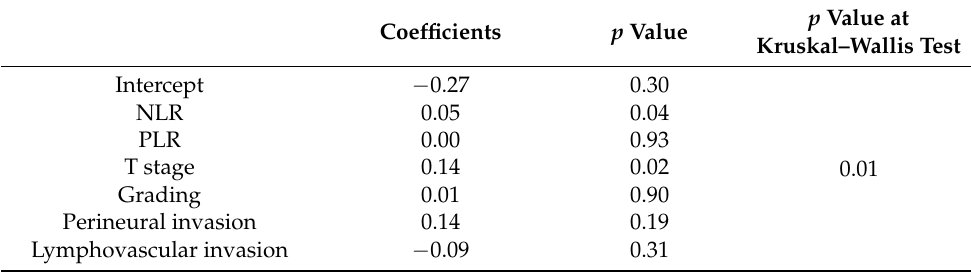
Table 4. Multivariate analysis considering linear regression of all clinico-pathologic